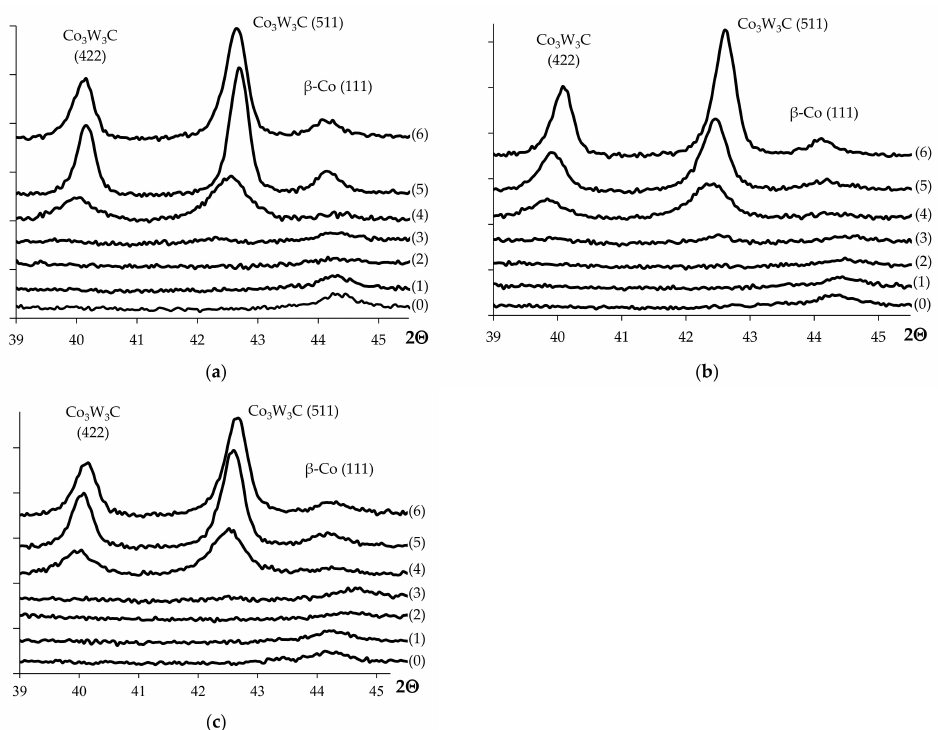
Figure A2. Fragments of the XRD curves from the WC-10Co hard alloy specimens after successive mechanical grinding of the surfaces: ( a ) the specimen sintered without degassing; ( b , c ) the specimens sintered with degassing at 850 ◦ C for 10